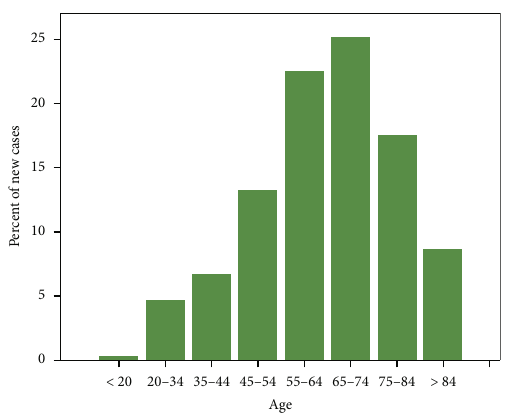
Figure 4: Percentage of new cases for melanoma skin cancer w.r.t. age structure groups in United State from 2014 to 2018 (Source: [3]).